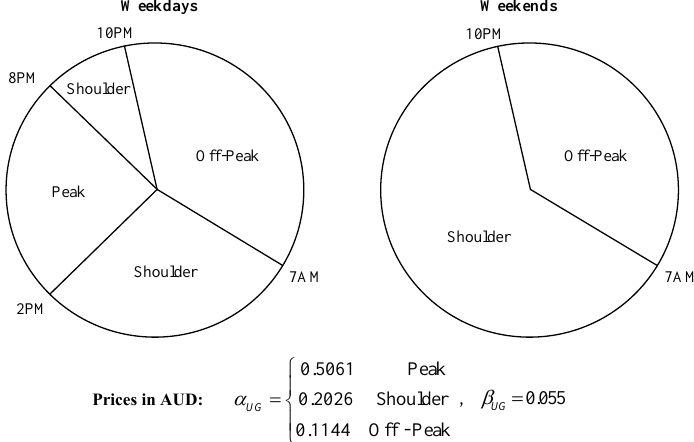
Figure 2. Illustrative example of time-of-use (TOU) electricity price and solar feed-in